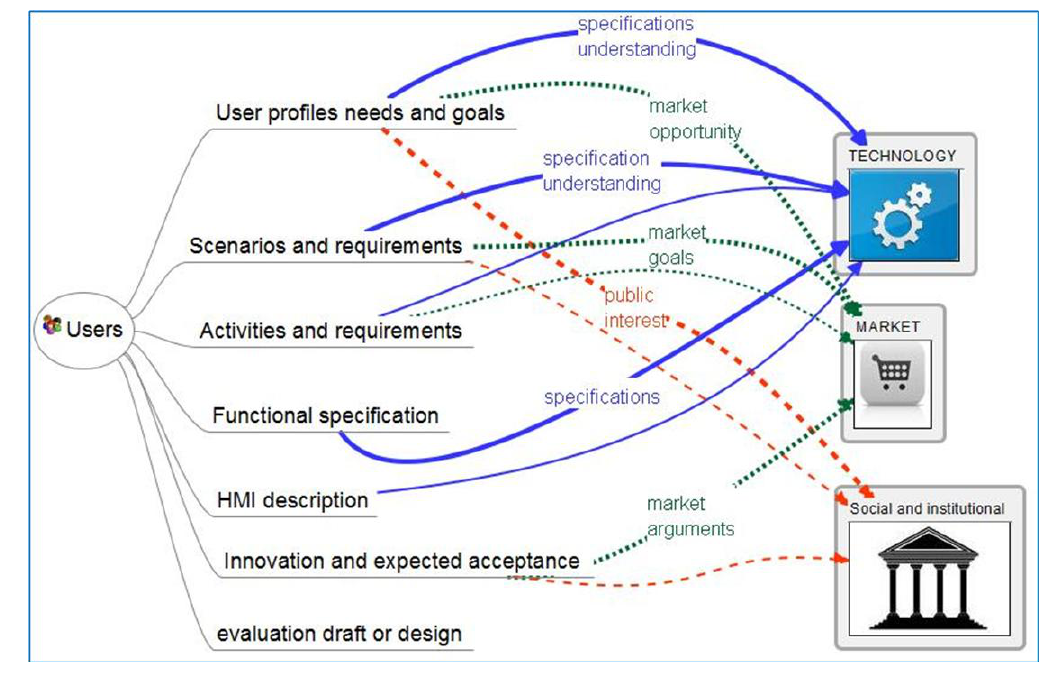
Figure 2. Cross relation of information-bits generated by user-oriented professionals among different professional groups.